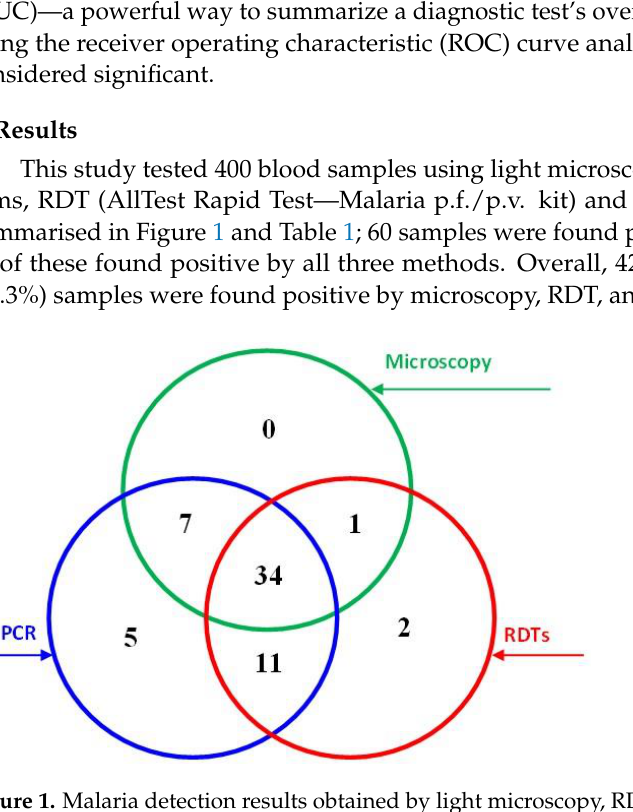
Figure 1. Malaria detection results obtained by light microscopy, RDT, and PCR techniques. Most of the 45 samples found positive by both PCR and RDT were among male (77.8%), rural (64.4%), and non-Saudi (82.2%) participants; 44.4% were among participants aged 18–30, and 58.5% were in samples with low parasite density. Similar results were found in the 41 samples found positive by both microscopy and PCR. Two RDT-positive samples were considered false positives based on both microscopy and PCR; 16 (4.5%) were considered false negatives among the microscopy-negative samples. Interestingly, 12 PCR- positive samples were found negative by RDT, one of them with moderate parasite